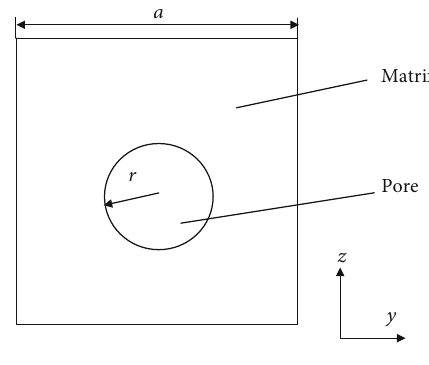
Figure 5: Spherical pore model.